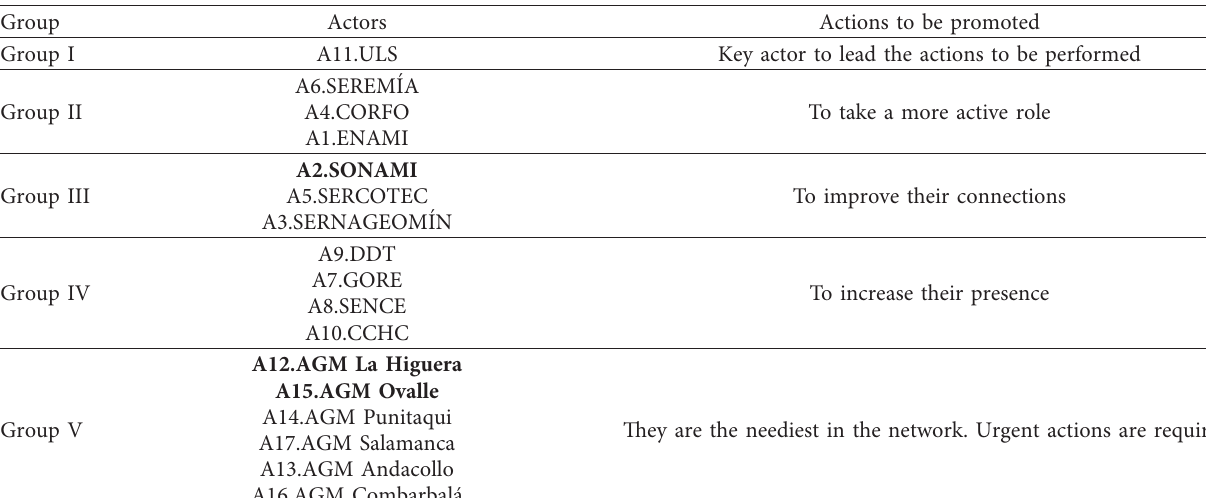
Table 8: Groups of